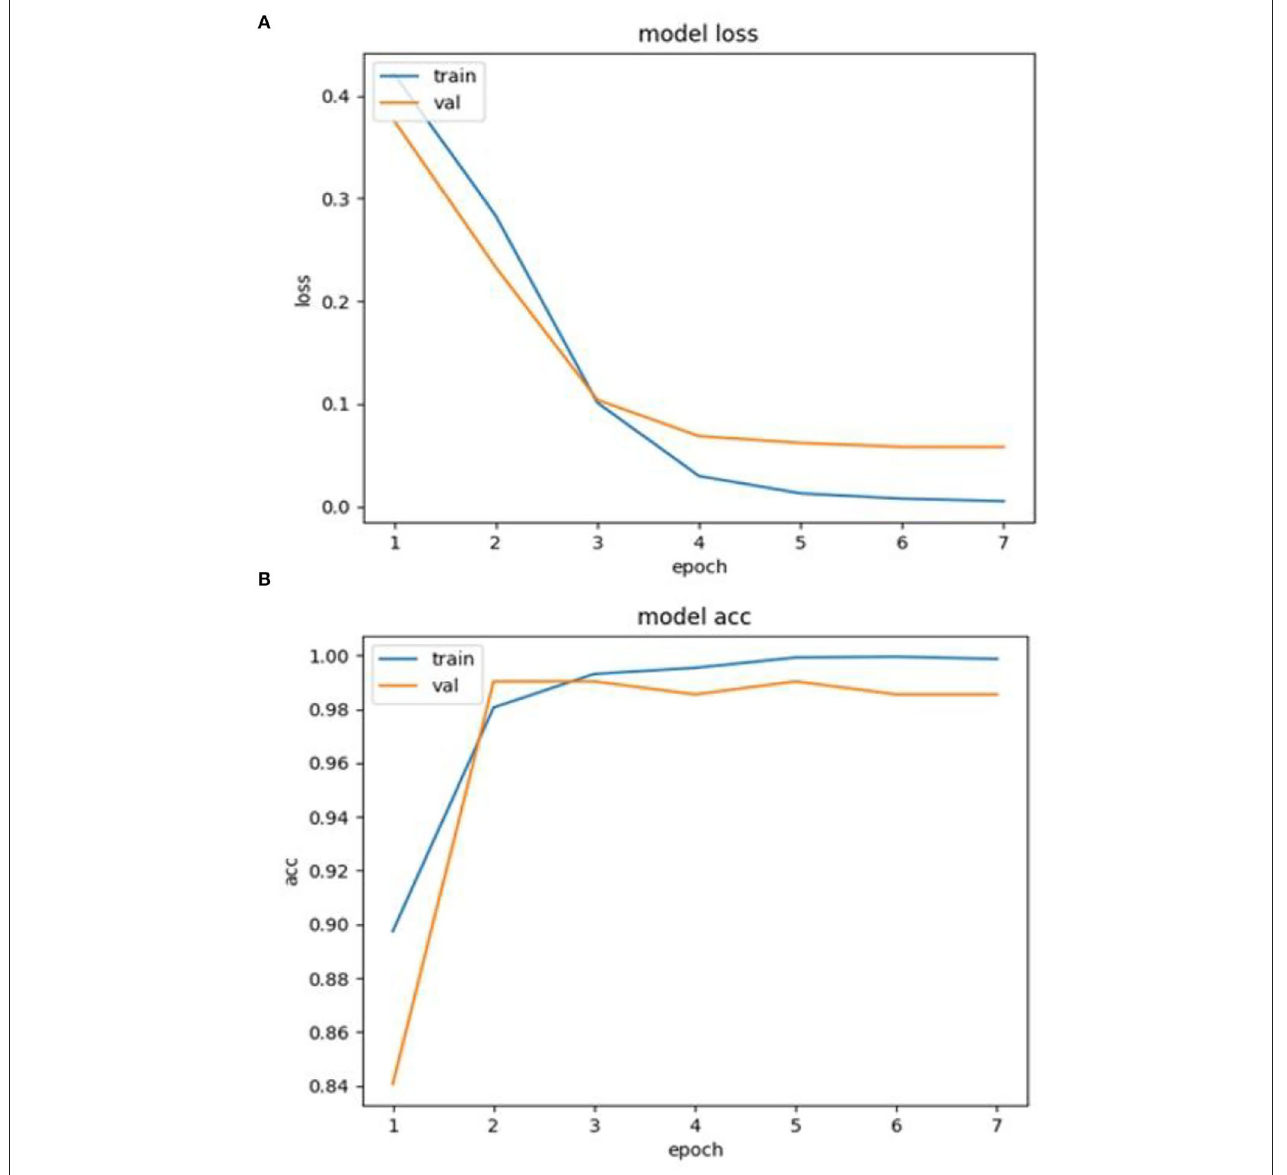
FIGURE 8 | (A) Loss and (B) accuracy of RNN model.